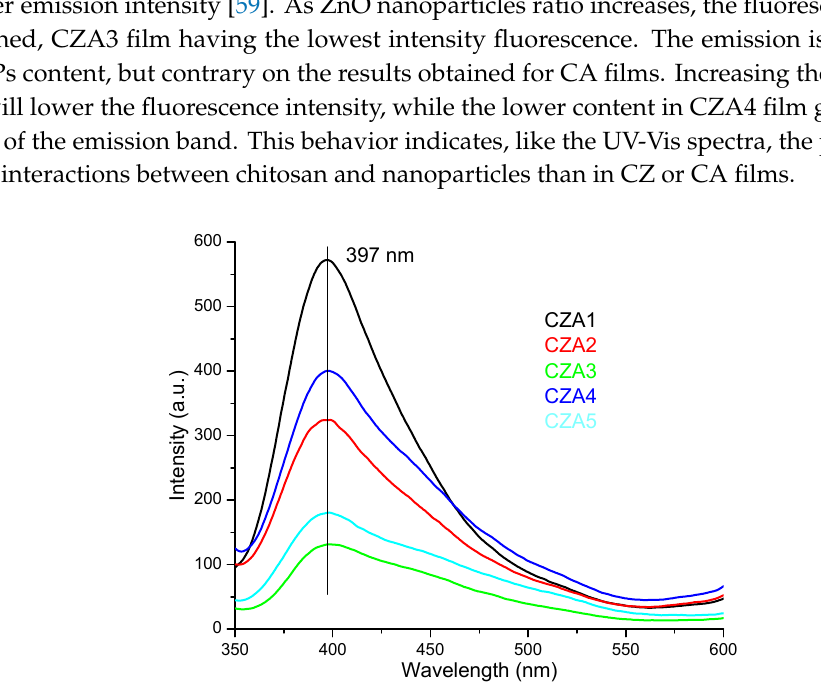
Figure 7. The photoluminescence spectrum (PL) spectra for chitosan and CZA1–CZA5 films.